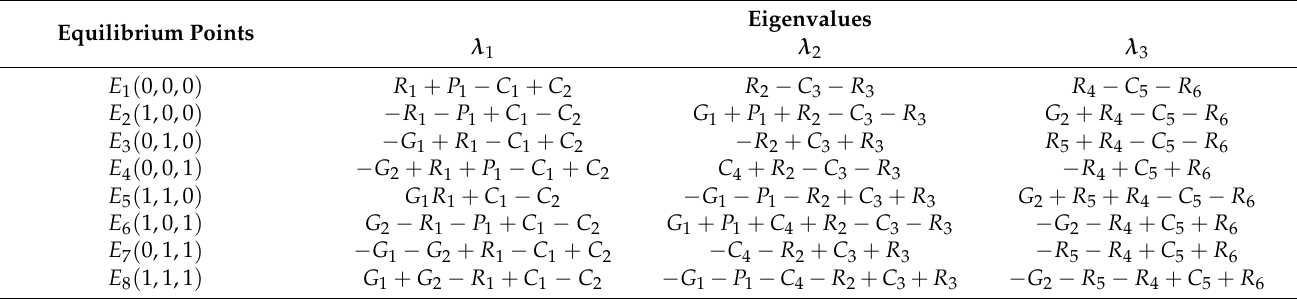
Table 4. Evolutionary game payoff matrix.